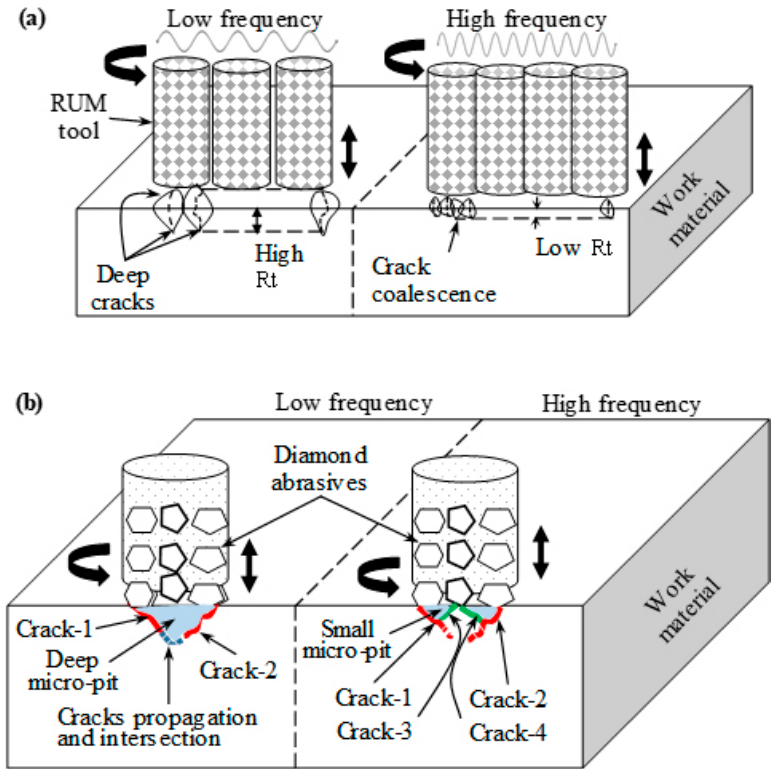
Figure 12. ( a ) Schematic illustration of the effect of vibration frequency on Rt; ( b ) crack propagation and